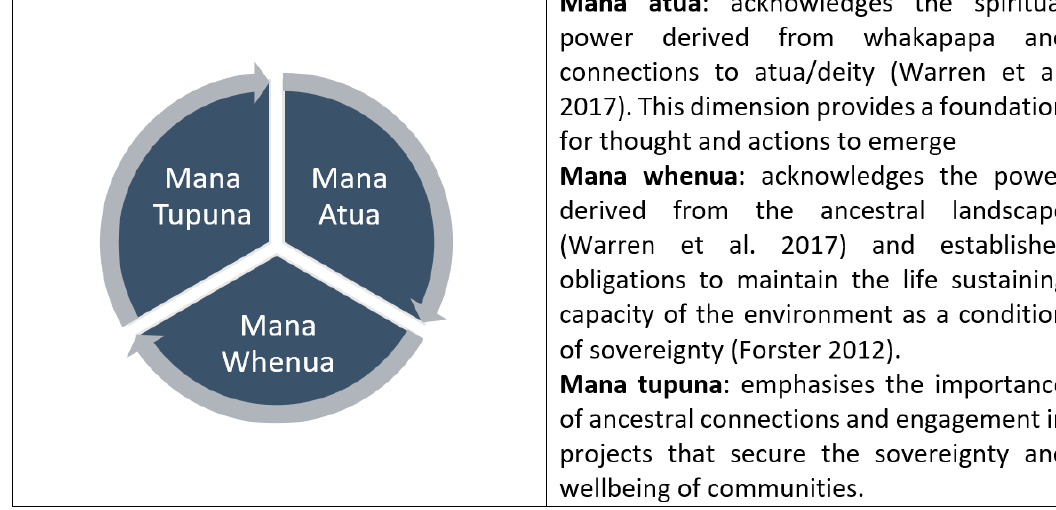
Figure 4. The role of mana and mauri in governing environmental conduct.